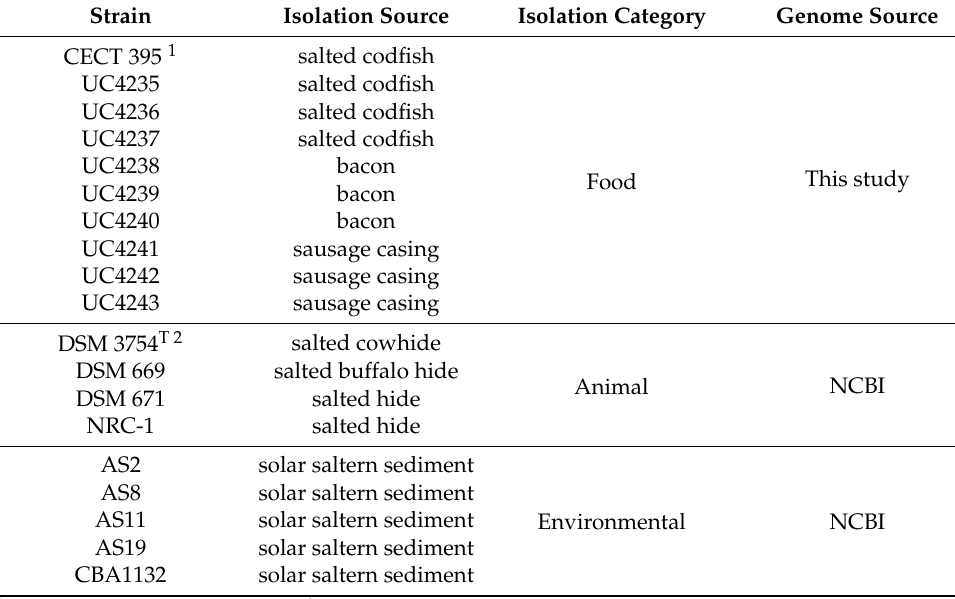
Table 1. H. salinarum strains investigated in this study. Strain Isolation Source Isolation Category Genome